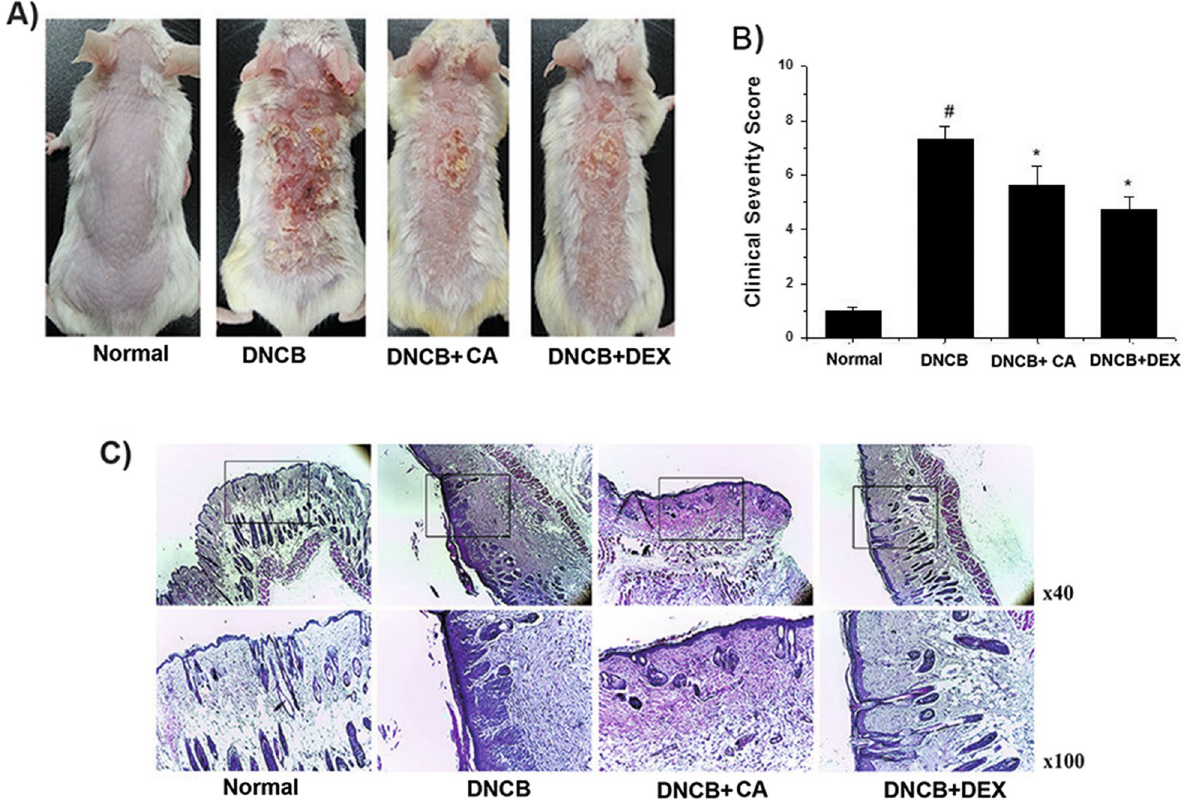
Fig. 2 Effect of CA on DNCB‑induced AD in mice. A Clinical feature of AD‑like skin lesions in mice. B The score of skin severity is represented. C Epidermal thickness in skin was analyzed in the H&E‑stained sections (magnification data represents the